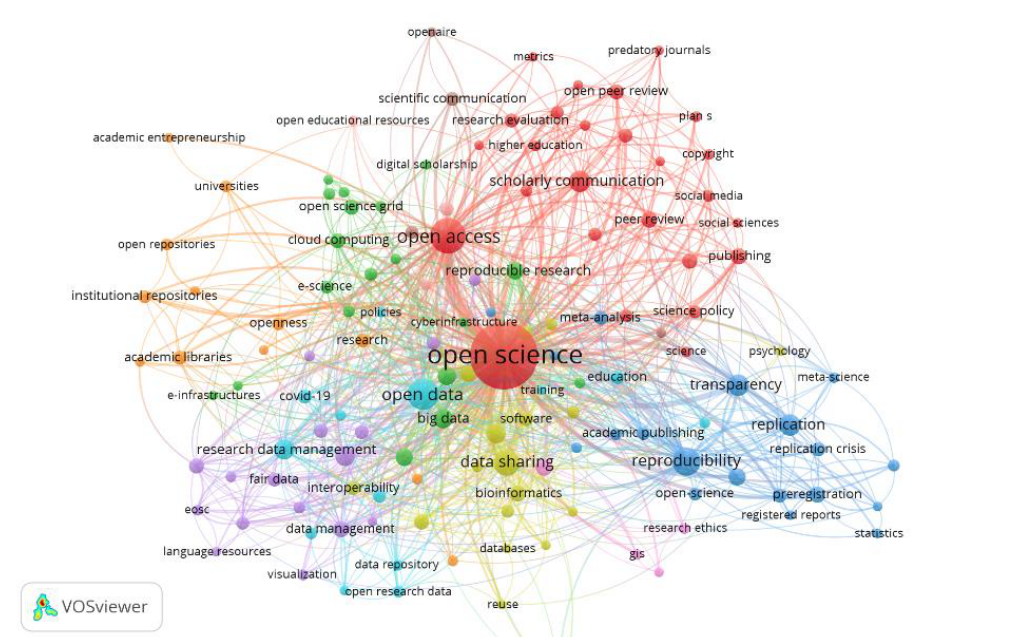
Figure 4. The Result of the Clustering of Categories in Publications Based on the Search Query “Open Science” in Scopus Source: Compiled by the authors using VOSViewer (VOSViewer,